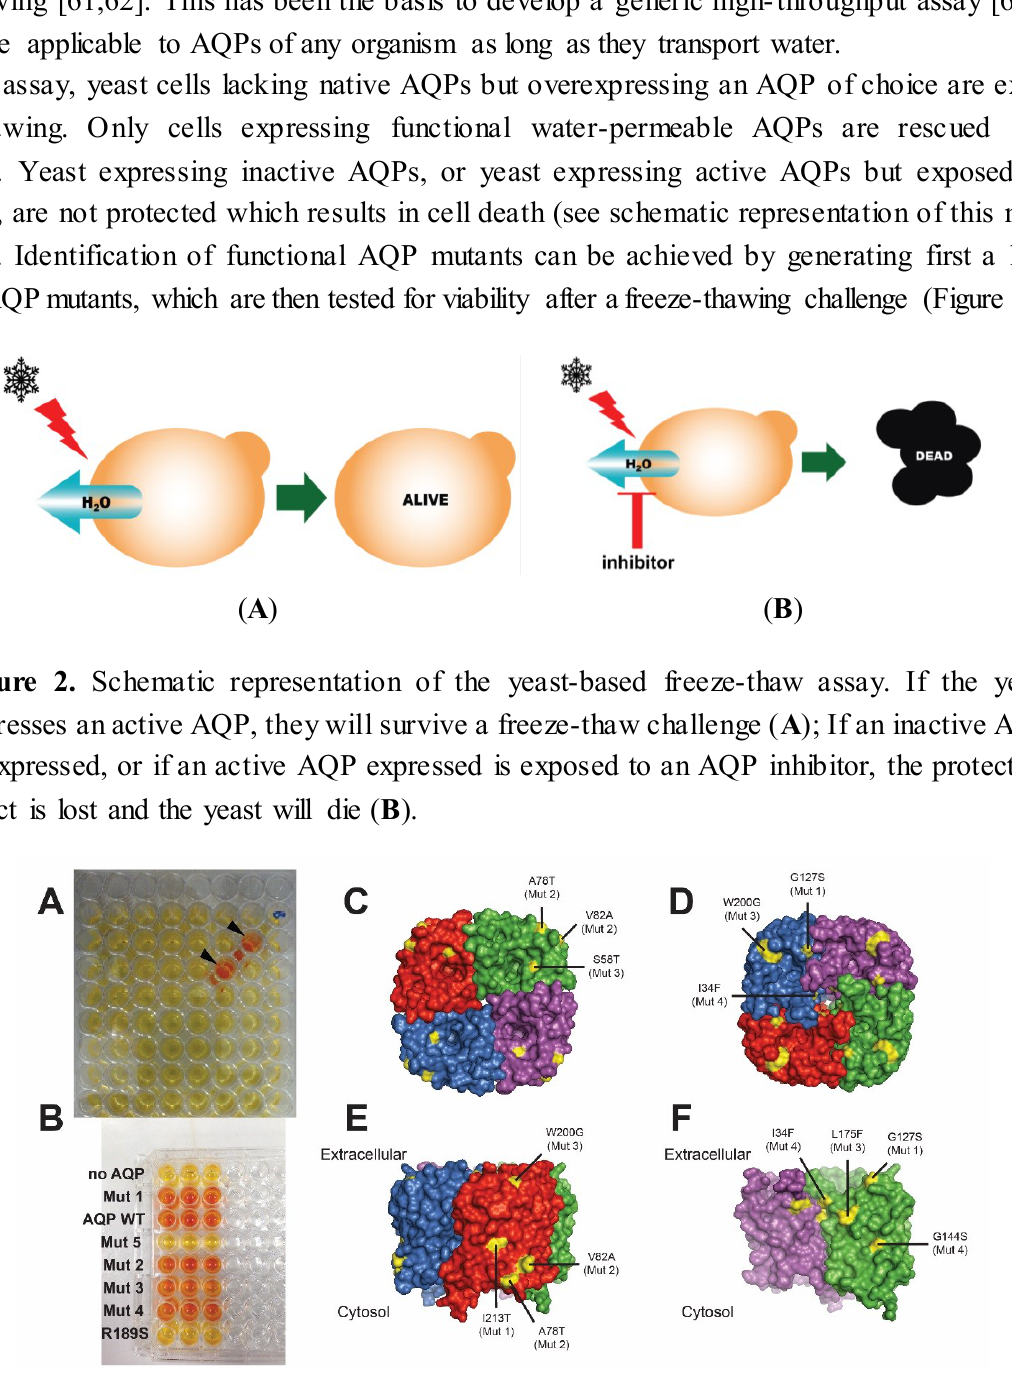
Figure 3. Selection of functional AqpZ mutants. ( A ) Screening of a 96-well plate with yeast expressing AqpZ mutants, showing two wells with water-permeable AqpZ (arrows). Conversion of added reagents to orange colour indicates presence of viable cells; ( B ) Re-screening comparing yeast without AQP or expressing wild type AqpZ (WT), an inactive mutant (R189S) and several inactive/active mutants found; (C-F) Nine functional mutations (yellow), out of 160 mutants carrying 1–5 mutations each, shown on the structure of the AqpZ tetramer: view from ( C ) cytoplasmic and ( D ) extracellular side; ( E , F ) side view ( E ) and after removing two monomers ( F ). Results adapted from